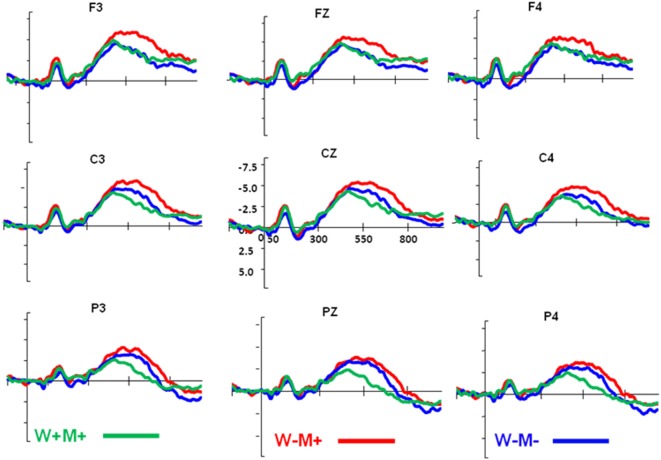
Event-related potentials (ERPs) across different priming conditions from the nine representative electrodes. The green line represents the W+M+ condition, the red line represents the W−M+ condition, and the blue line represents the W−M− condition. The unit of vertical coordinate is μV.